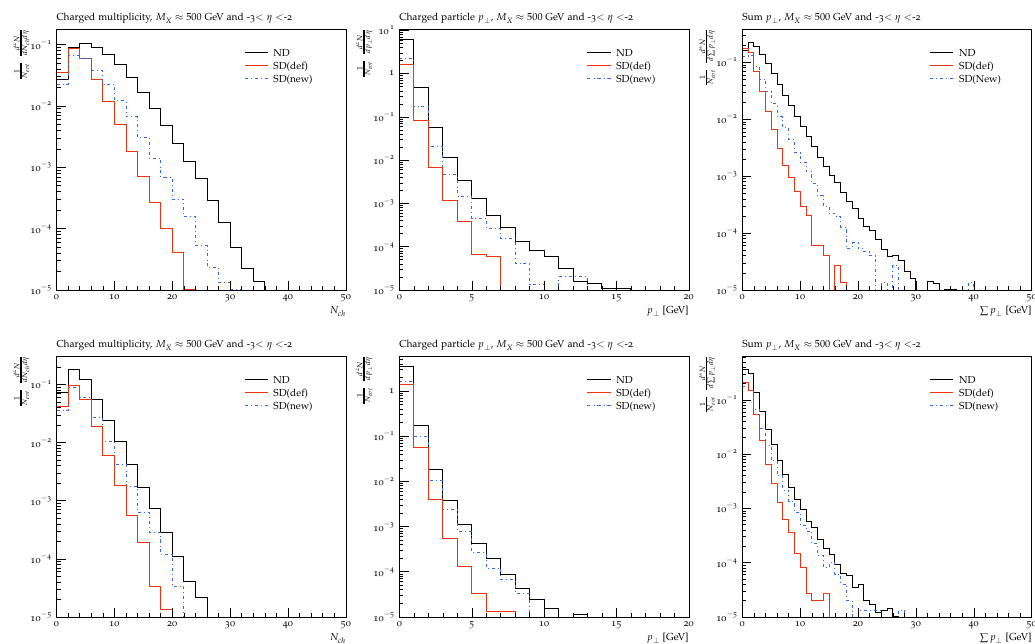
Figure 9 . Multiplicity, p ? and p ? of charged particles for di(cid:11)erent modi(cid:12)cations of SD events with M X 500 GeV compared to ND events in the pseudo-rapidity interval P (cid:25) events were generated at (cid:12)xed impact parameter, b= b = 0 : 9 (top panel) and 1 : 3 (bottom panel). h i The lines are as in (cid:12)gure